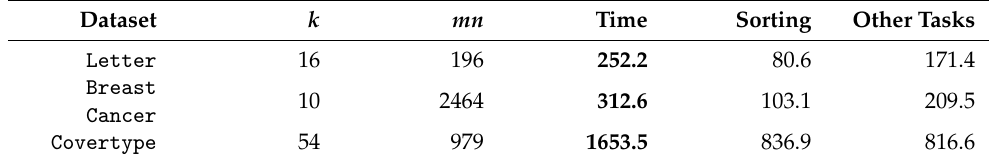
Table 8. Running time (s) of improved algorithm for real data in UCI Machine Learning